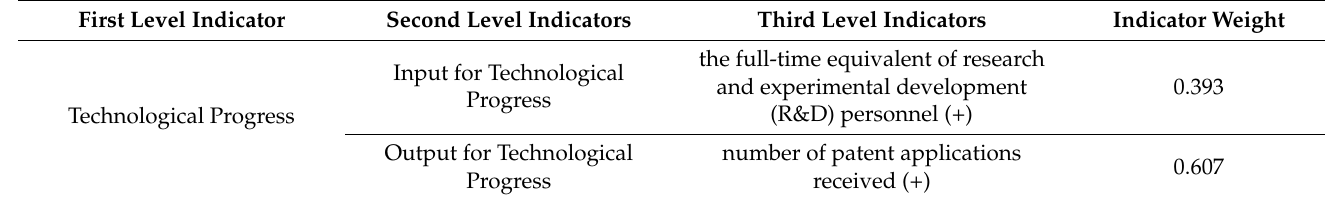
Table 2. Index evaluation system and weight for technological progress.